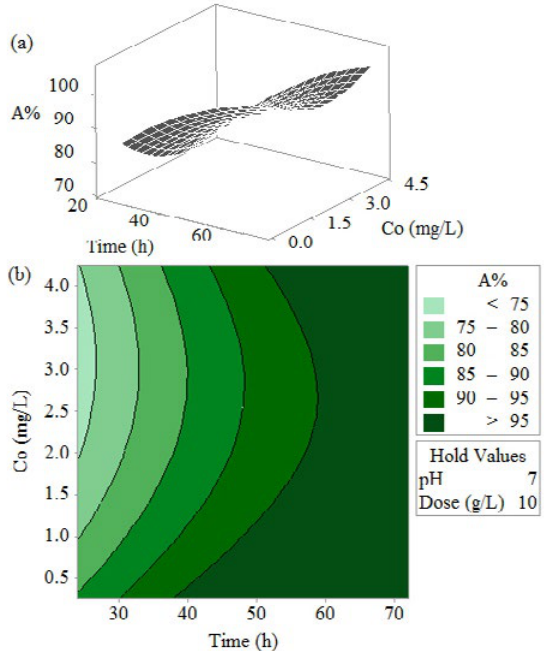
Fig. 8: Effect of contact time and initial adsorbate concentration on the removal efficiency: (a) 3D response surface and (b) 2D contour plots